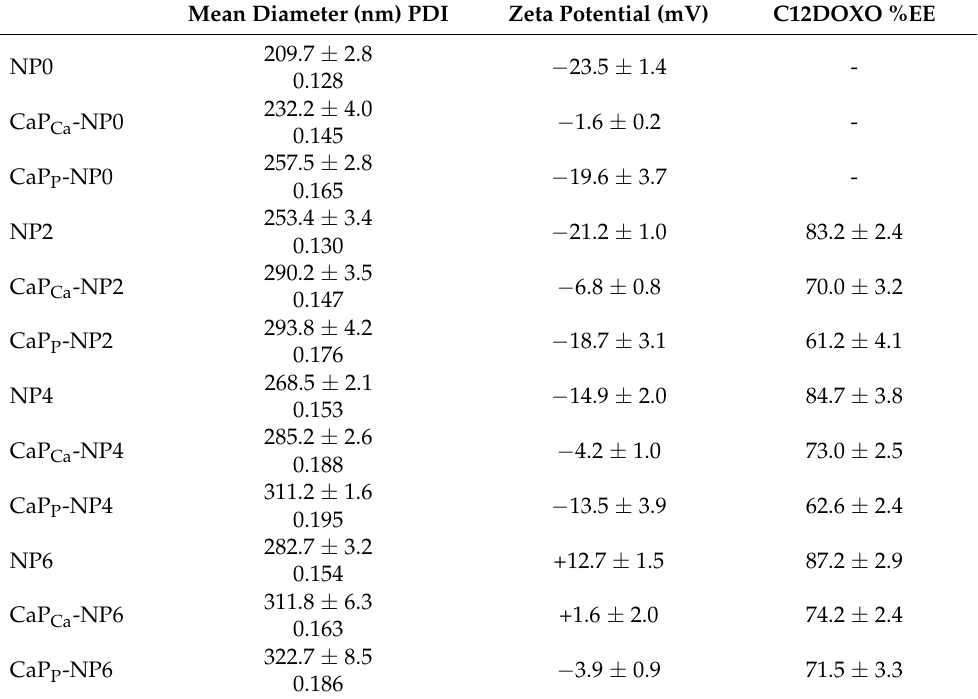
Table 2. Mean diameter, Zeta potential, and drug entrapment efficiency of different